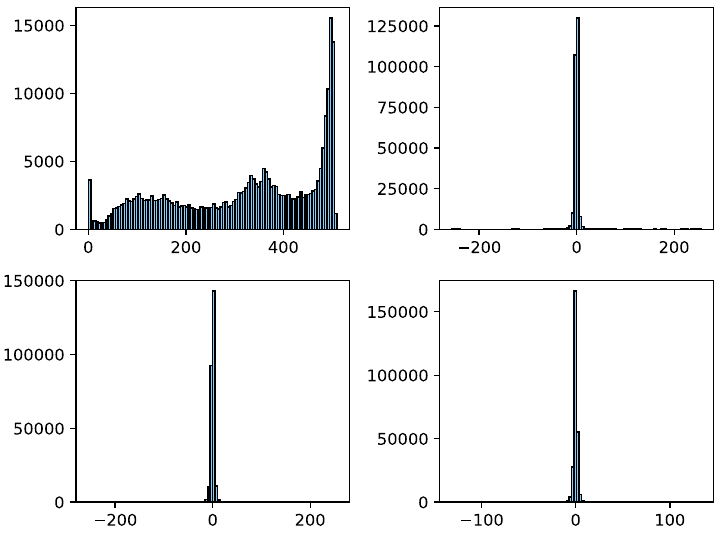
Figure 3. Grayscale image and heat map of the same transformed image in wavelet domain.